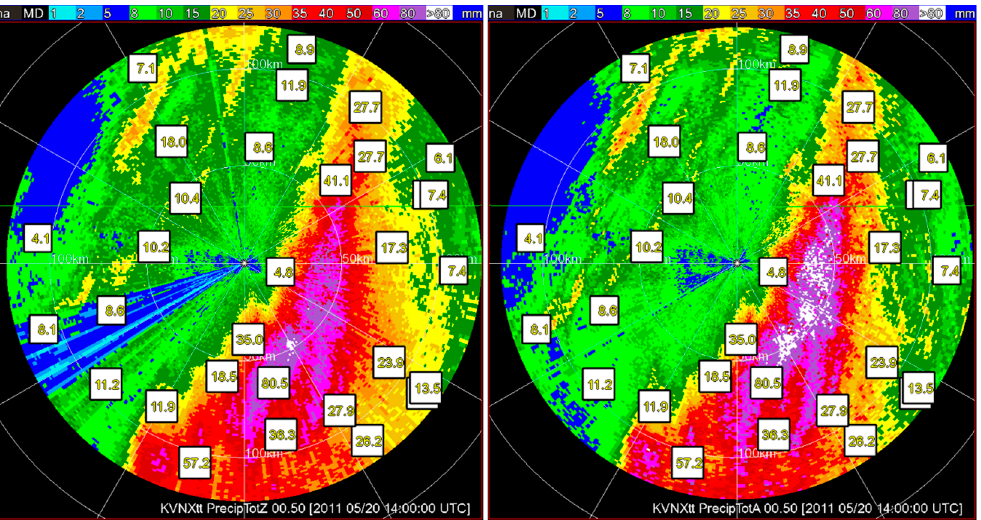
Figure 7. Maps of 6-h rain total obtained from the KVNX WSR-88D radar on 20 May 2011 (0800–1400 UTC) using R ( Z ) and R ( A ) algorithms. Gauge accumulations (mm) are displayed in white squares.